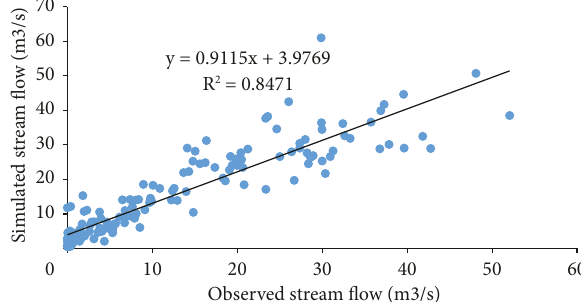
Figure 11: Scatter plots of observed and simulated daily streamflow for the Nashe watershed during the calibration period.